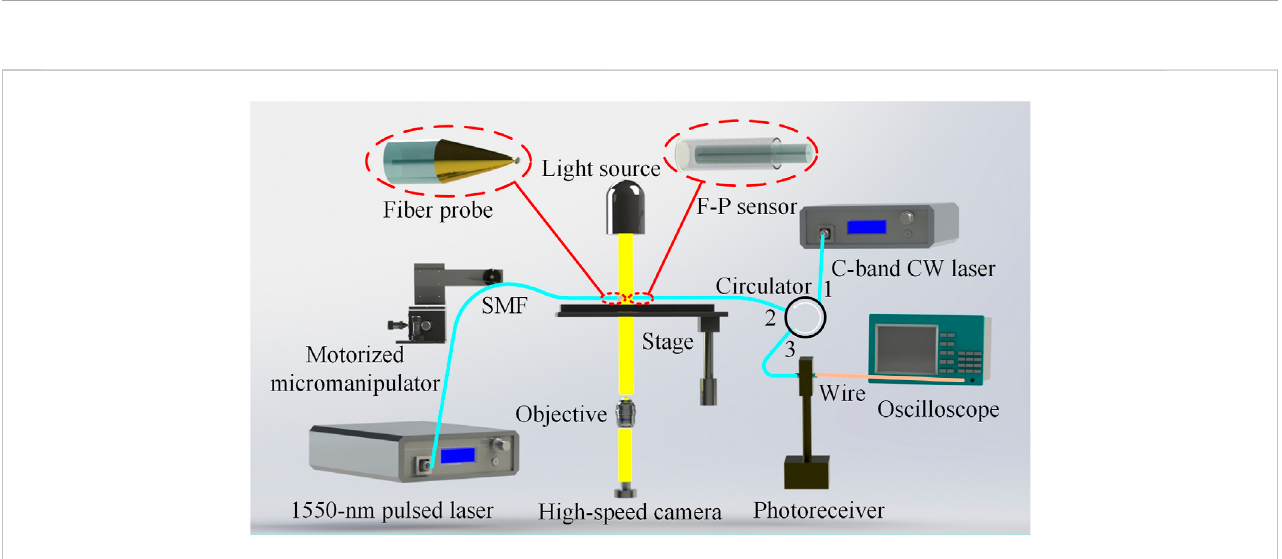
Experimental setup for probing micro-explosion. This fi gure is not to